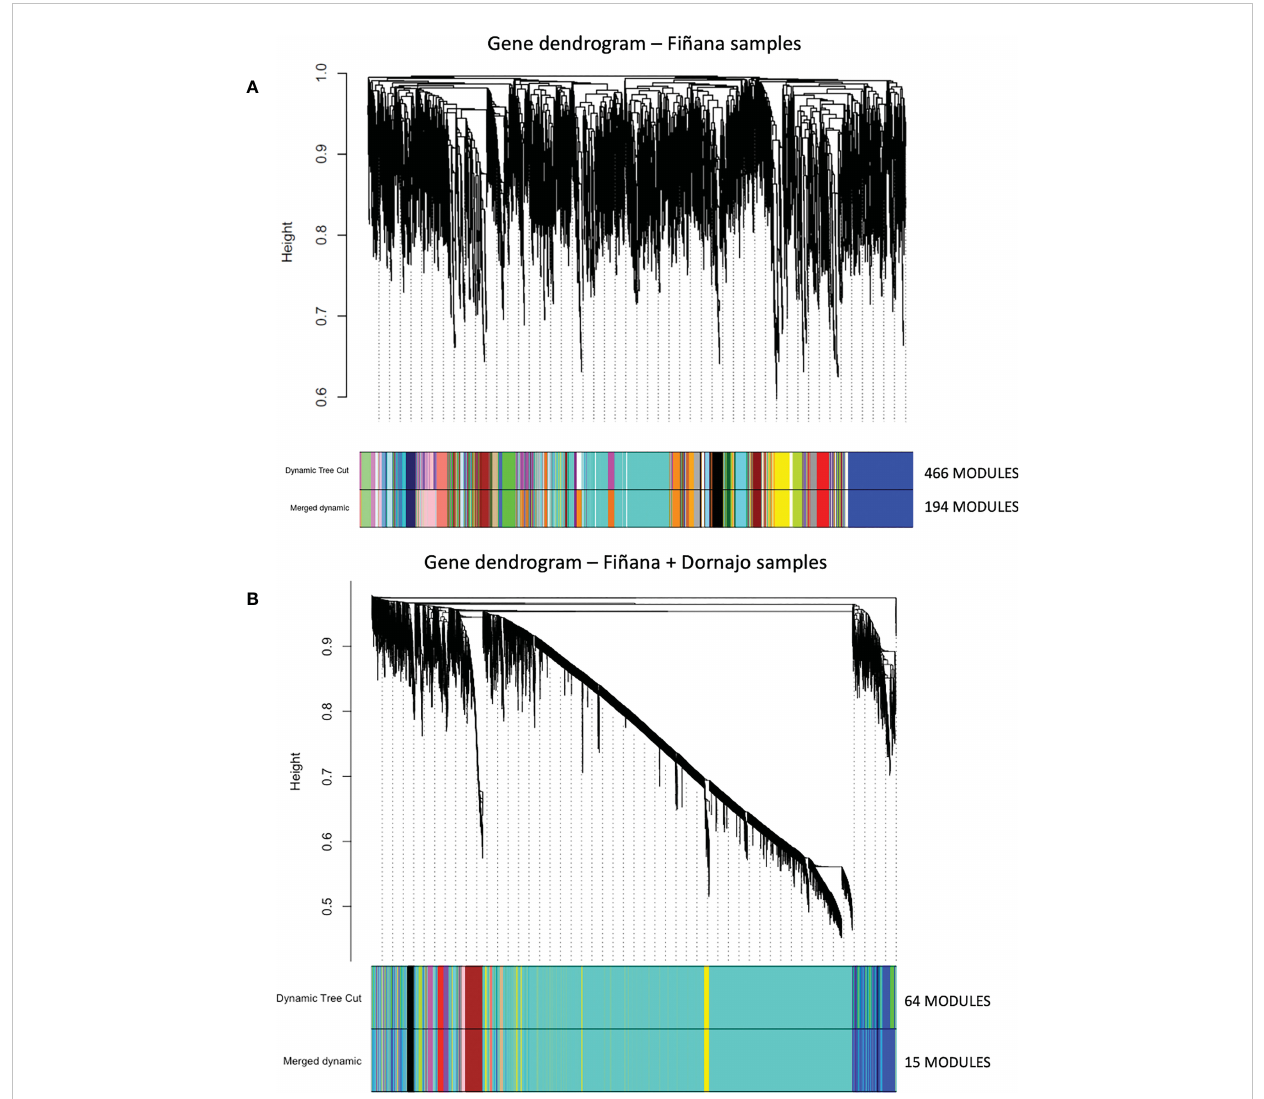
FIGURE 6 Hierarchical cluster dendrogram showing co-expression modules using weighted gene co-expression network analysis (WGCNA) of the counts to identify gene modules underlying drought stress at four different treatments and responses (C, I, R and N) in Fiñana (A) and Fiñana+Dornajo populations (B) . (A) 466 modules corresponding to branches are labelled with colours indicated by the colour bands underneath the tree. With 0.25 threshold merging, 194 modules were generated. (B) 64 modules corresponding to branches are labelled with colours indicated by the colour bands underneath the tree. With 0.25 threshold merging, 15 modules were